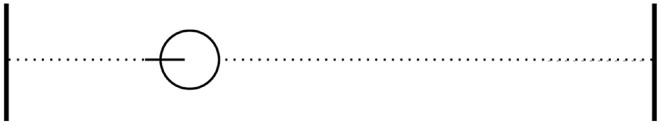
A robot is moving on a line. At the end of the line, bumping into a wall causes stimulation. Turning around stops the stimulation by allowing the robot to move away from the wall.